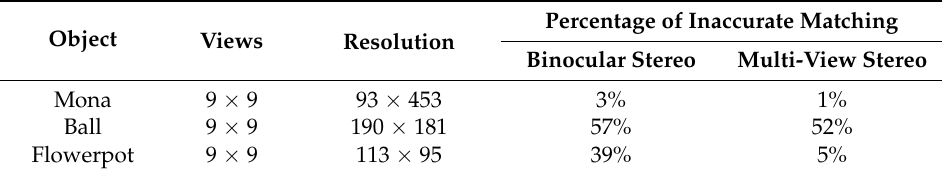
Table 1. A summary of the stereo matching results of the identified